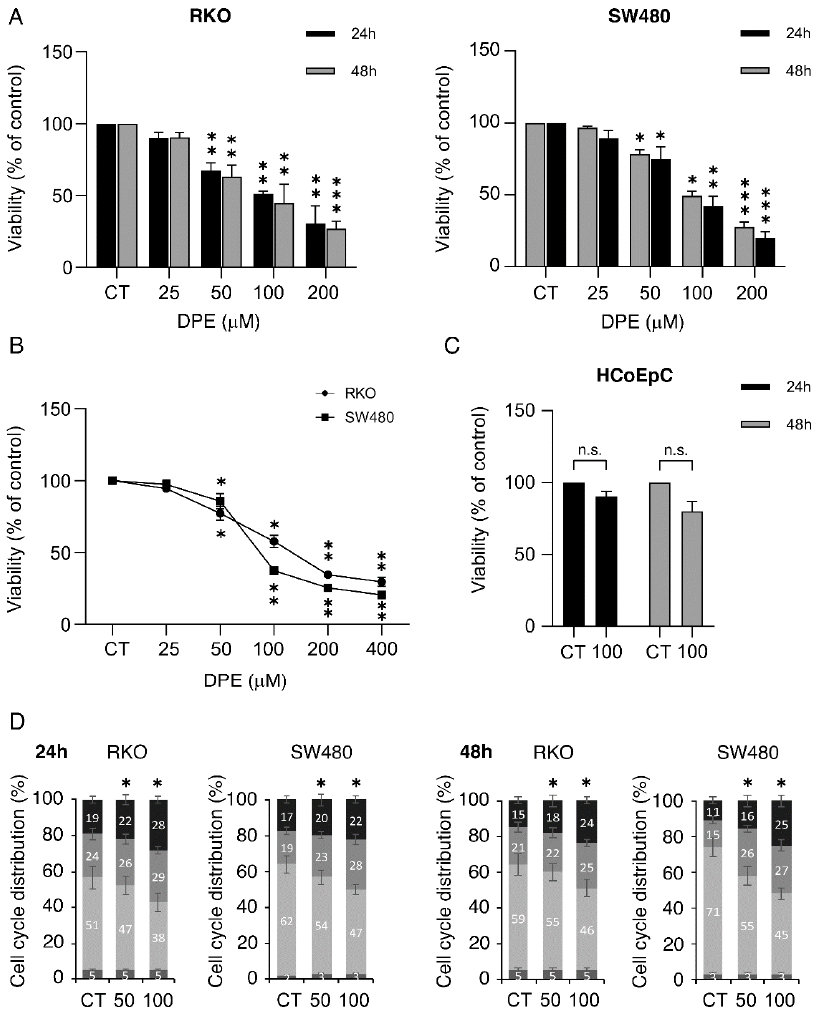
Figure 1. Dose–time–response inhibition of proliferation and S-G2 cell cycle arrest induction by DPE in colon cancer cells: ( A ) cell viability of RKO and SW480 cell lines treated with different doses of DPE (25, 50, 100 and 200 μ M) or left untreated as control (CT), as measured by a trypan blue exclusion assay after 24 or 48 h of treatment; ( B ) cell proliferation of RKO and SW480 cell lines treated with different doses of DPE (25, 50, 100, 200 μ M and 400 μ M) or control, as measured by MTT assay after 24 h; ( C ) cell viability of human colonic epithelial cell (HCoEpC) lines treated with DPE (100 μ M) or left untreated as control, as measured by a trypan blue exclusion assay after 24 or 48 h of culture; ( D ) cell cycle analysis of RKO and SW480 treated with DPE (50 or 100 μ M) or untreated for 24 or 48 h, as evaluated by FACS analysis after staining with PI. One representative out of three experiments is shown. The bars represent the means of the percentages of cells in each phase of the cell cycle (subG1, G1, S, and G2) plus S.D. of three experiments. Note: *** p < 0.001, ** p < 0.01, * p < 0.05. Not significant (n.s.). 3.2. DPE Activated all UPR Branches and Induced Dose-Dependent Upregulation of CHOP We next assessed the impact of DPE on the activation of all three main UPR sensors, IRE1alpha, PERK, and ATF6 in both wtp53 RKO and mutp53 SW480 cell lines. As shown in Figure 2A, the ATF6 full-length form was reduced, as occurs when it is activated. Indeed, in the course of ER stress, ATF6 translocates from ER to the Golgi apparatus where it undergoes proteolysis and becomes an activated transcription factor [14]. Moreover, the spliced form of XBP1, resulting from IRE1alpha endoribonuclease activity, also increased in DPE-treated cells and finally PERK was activated, as the phosphorylation of its target